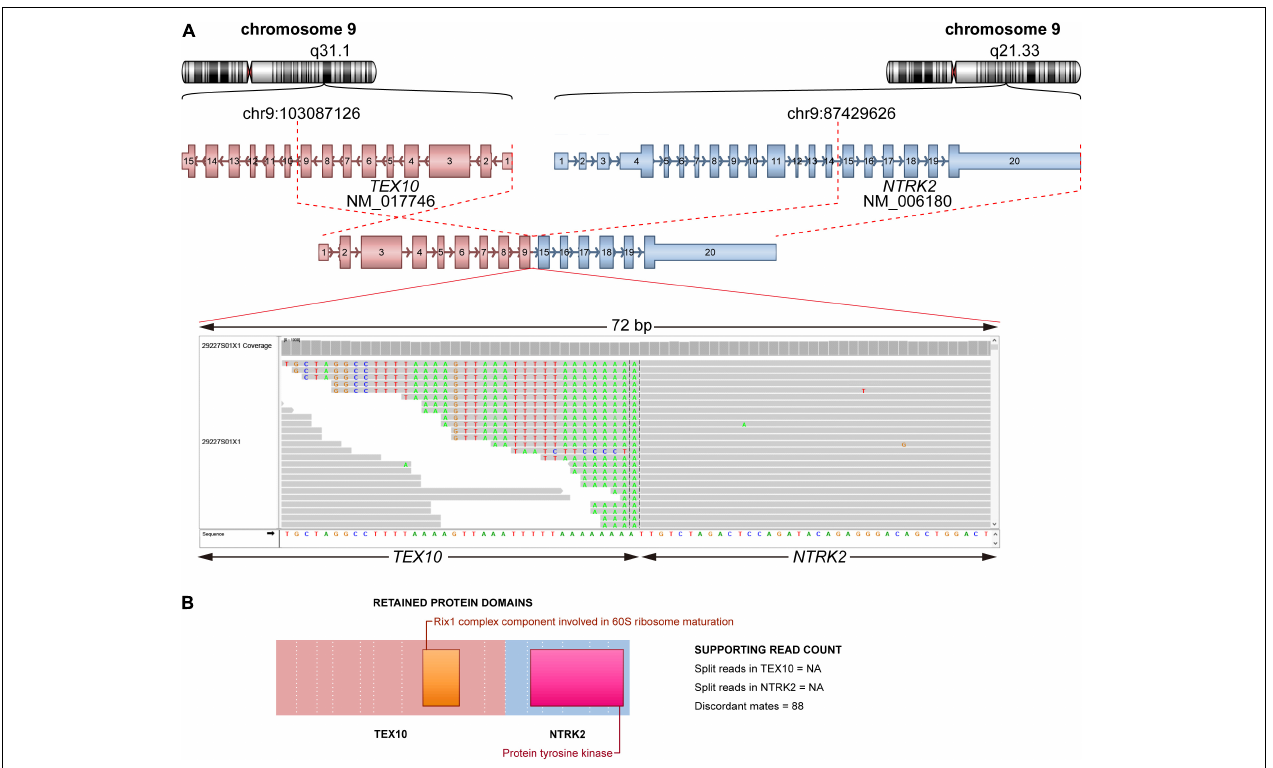
FIGURE 3 | Schematic plot of fusion of TEX10 - NTRK2 . (A) Representation of fusion TEX10 - NTRK2 . Top: chromosome and cytoband where breakpoint located on for each partner gene. Middle: fusion form ( TEX10 exon 1–9 joined NTRK2 exon 15–20). Bottom: reads spanning breakpoint using IGV. (B) Retained protein domains of each partner